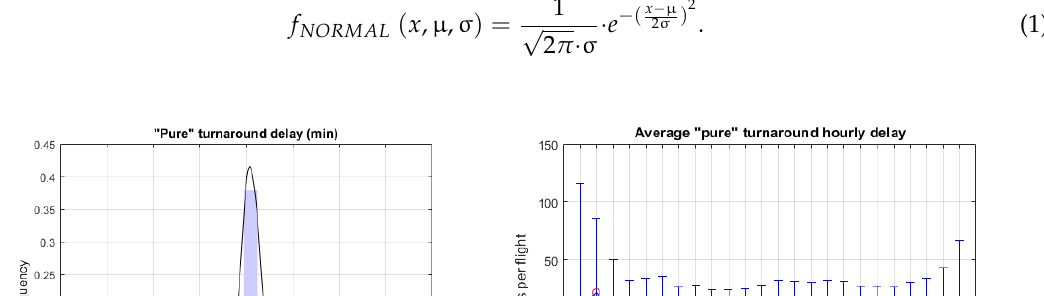
Figure 9. Histogram and distribution fitting for turnaround: ( a ) actual duration (min), ( b ) starting time delay (AIBT–SIBT) (min), and ( c ) finishing time delay (AOBT–SOBT) (min).